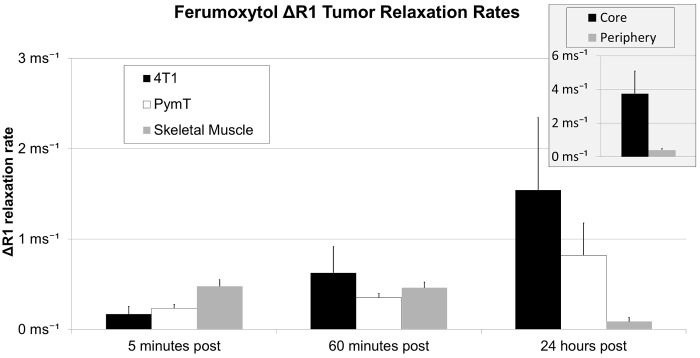
4T1 tumors with central necrosis exhibit significant T1-enhancement.Difference between pre- and post-contrast R1 relaxation rates (ΔR1 relaxation rates) of 4T1 tumors, PymT tumors as well as skeletal muscle. Data are displayed as mean data of six tumors in each group and standard deviations. Insert shows ΔR1 data of 4T1 tumor core versus periphery at 24 hours. Tumor ΔR1 data at 60 minutes and 24 hours post contrast are significantly different from baseline values (p<0.05).